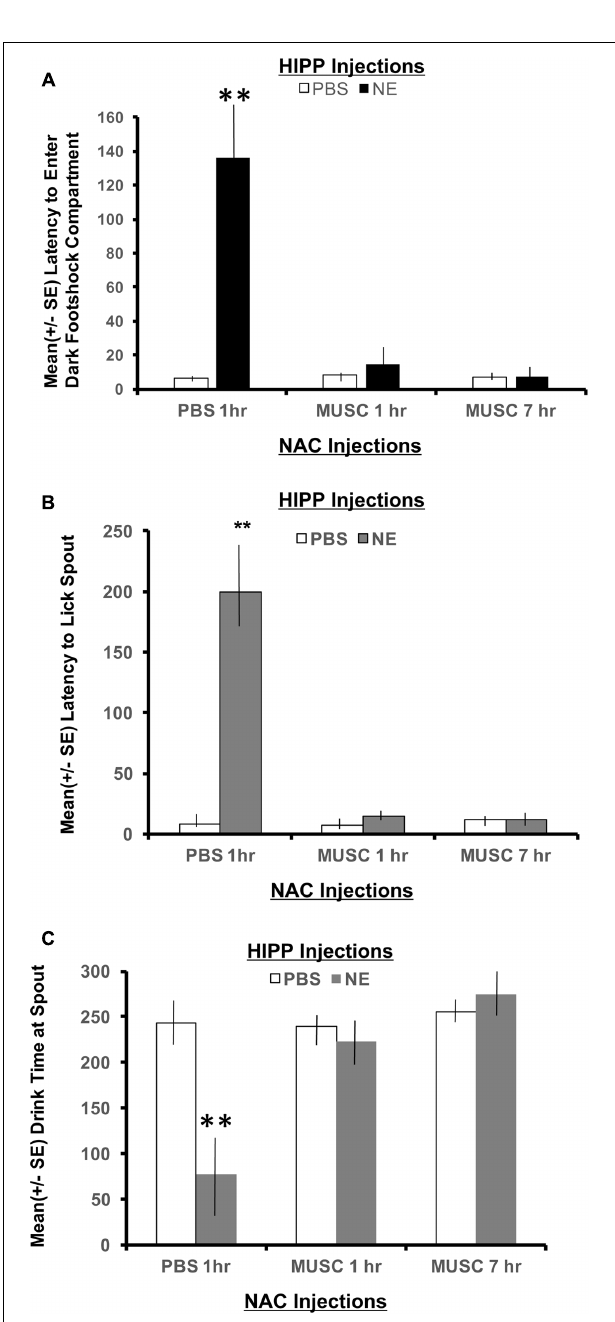
FIGURE 4 | (A) Mean (+ SE) latency to enter the compartment where shock was administered 24 h previously in animals with ventral hippocampal and accumbens shell cannulae implants. Only animals given norepinephrine in the hippocampus took significantly longer to enter the context where footshock had been delivered 24 h previously ( p < 0.01). Infusion of muscimol in the accumbens either 1 or 7 h later attenuated the memory enhancing effect ( p < 0.01 for NE/1 h MUSC and NE/7 h MUSC groups compared to NE/PBS group). These findings are in direct contrast to those depicted in Figure 3A for animals given the same dose of norepinephrine in the basolateral amygdala. ∗∗ denotes p < 0.01. (B) Mean (+SE) latency for animals with ventral hippocampal and accumbens shell cannulae implants to initiate licking from the spout after entering the dark compartment. Not only did animals